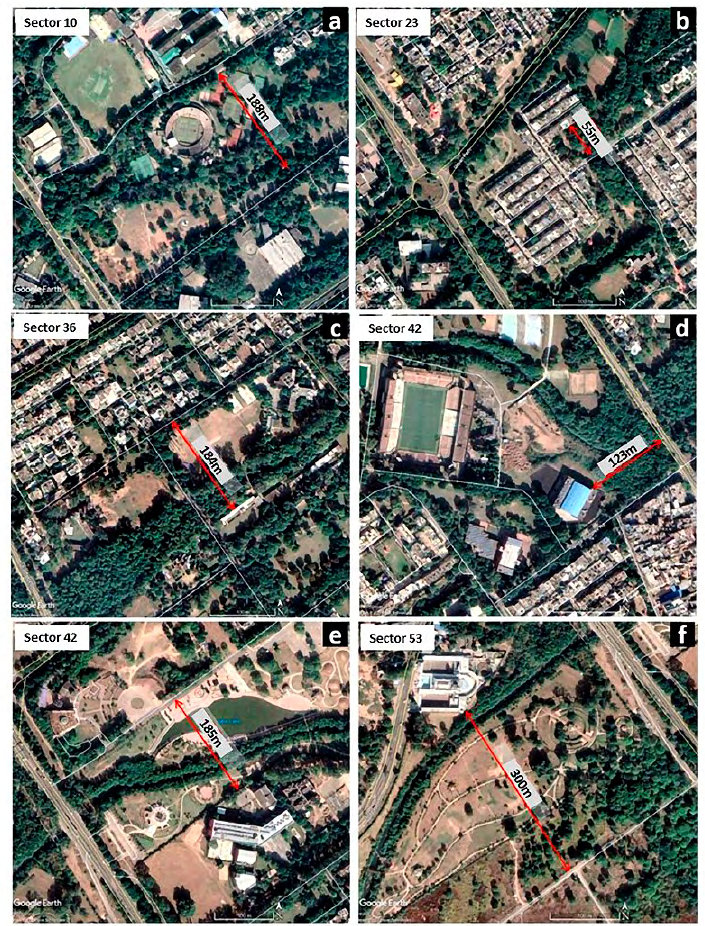
Figure 2. (a) In sector 10, the Leisure valley accommodates various sports courts within 188m width, (b) In sector 23, 55m wide section accommodates only the N-choe lined with fully grown trees, (c) Sector 36 has the N-choe with playgrounds within 184m width, (d) In sector 42, thick urban trees accompany the channel within 123m width, (e) To have a lake (water retention structure), the width at sector 42 is 185m, (f) The Leisure valley sees its maximum width of 300m in sector 53, accommodating a humongous park. Source: Developed by authors using Google